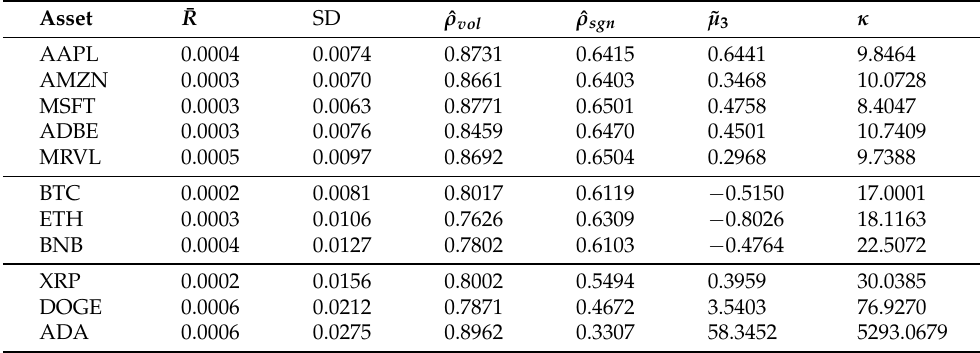
Table 1. Summary statistics of returns of Stocks and